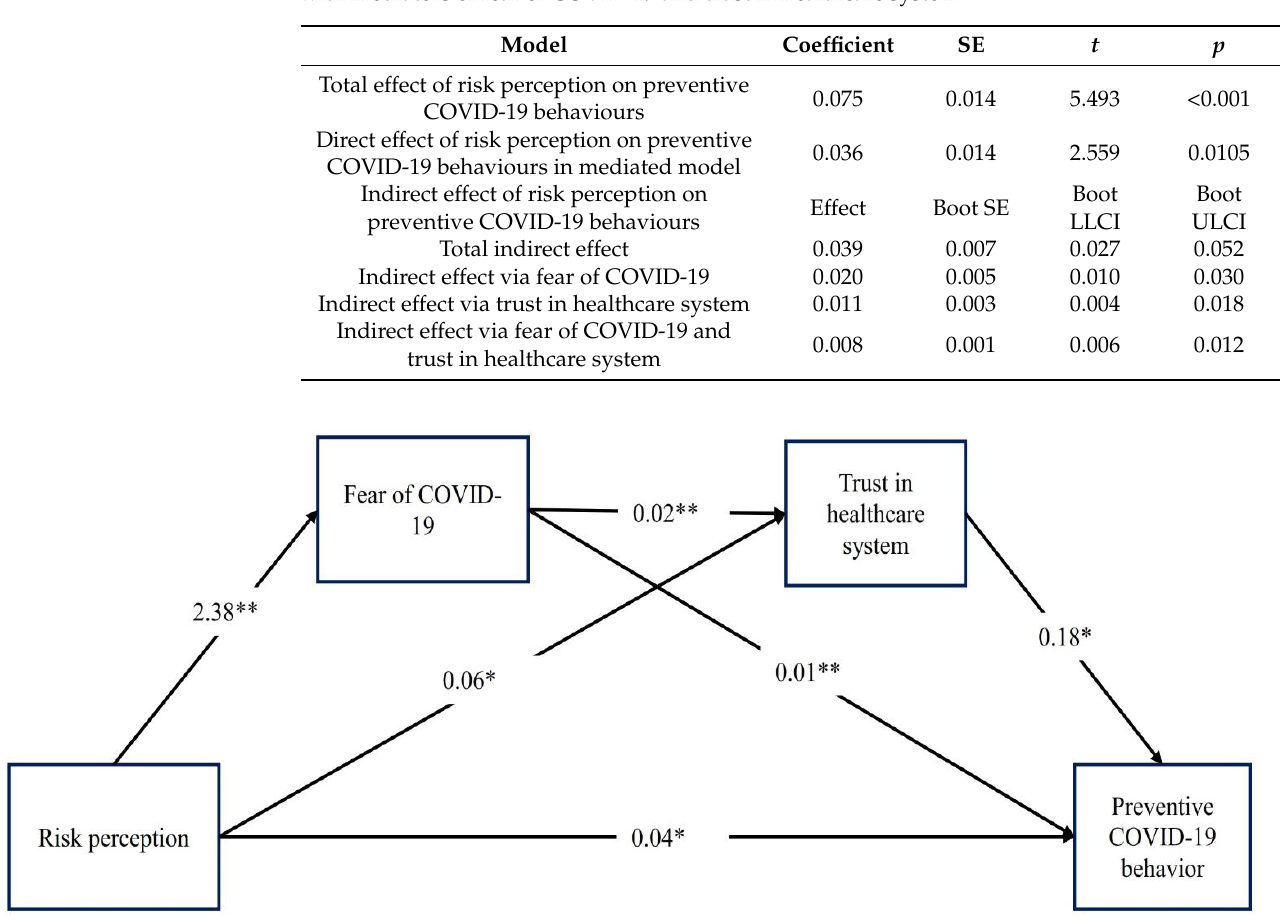
Figure 1. The serial multiple mediation model with fear of COVID-19 and trust in the healthcare system as proposed mediators of the effect of risk perception on performing preventive COVID-19 behaviours. * p < 0.05. ** p < 0.001. Note: Age, gender, educational status, marital status and living accommodation were adjusted in the model.